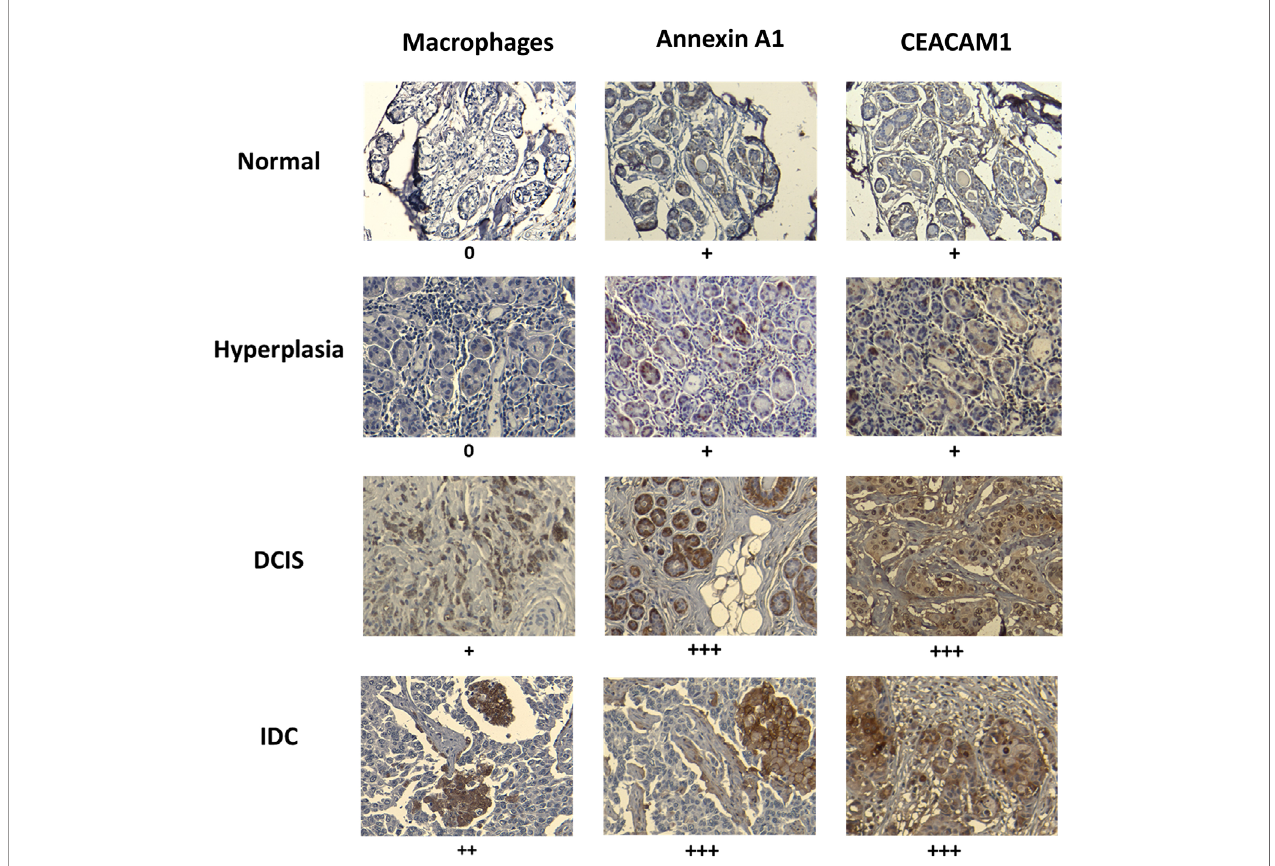
FIGURE 6 | Macrophage in fi ltration and expression of Annexin A1 and CEACAM1 in human breast tissues at various stages of transformation mirror the in vitro observed activation threshold. Example of paraf fi n-embedded samples of breast tissues, normal (1 of 8 total), hyperplasia (1 of 5 total), ductal carcinoma in situ (DCIS) (1 of 8 total) and invasive ductal carcinoma (IDC) (1 of 6 total), sectioned and stained with relevant antibodies (see Materials and Methods ). Slides were scanned at 10X magni fi cation in order to select for a high-resolution image at 20X. Images were scored by measuring the percentage of IHC positively labeled cells: +, <25%; ++, 25 to 50%; +++, 50 to 75%; and ++++ > 75%. Representative images are shown. The “ + ” signs refer to results from all analyzed samples in each tissue